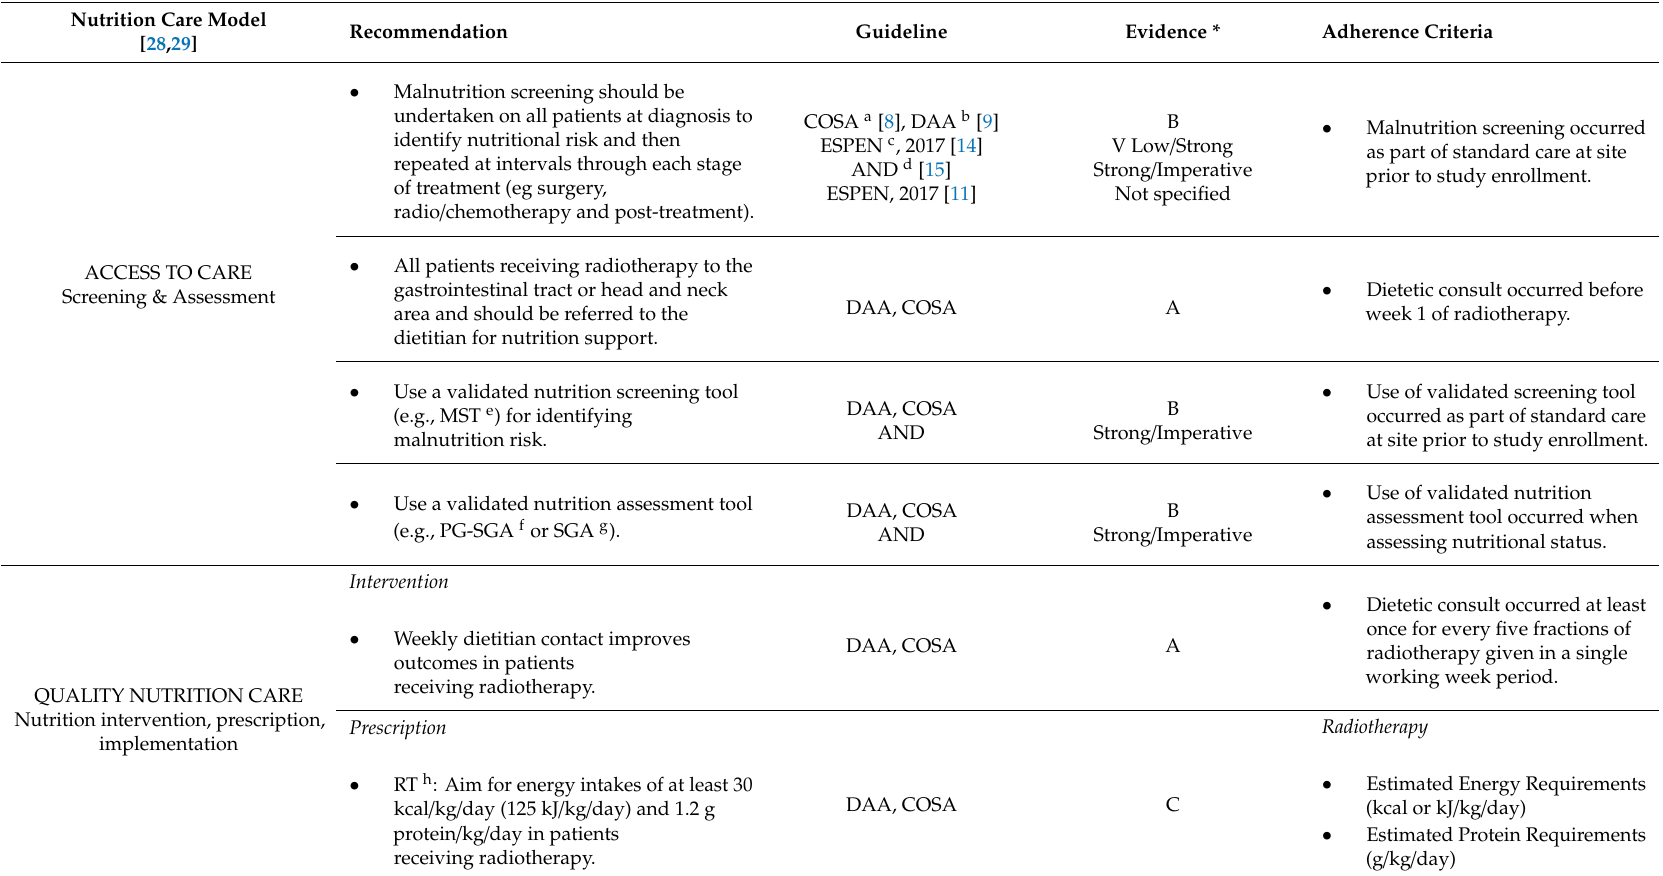
Table 2. Adherence criteria for evidence-based guideline